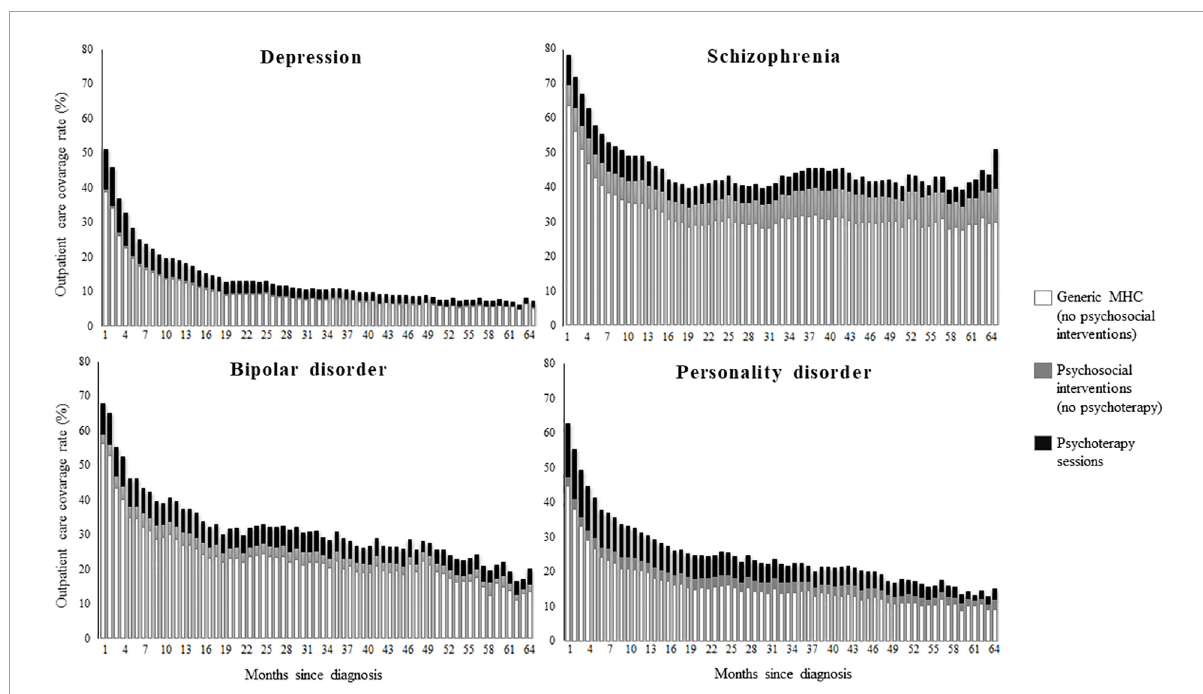
FIGURE3 Monthly coverage rate of contacts with the mental health service from the first until the 64th month after diagnosis of depression, schizophrenia, bipolar disorder, and personality disorder. Coverage was assigned to psychotherapy whether at least one psychotherapeutic session was performed, to psychosocial intervention whether at least any other psychosocial intervention was performed, to generic mental health care whether the patient attended the service without receiving neither psychosocial nor psychotherapeutic intervention. QUADIM-MAP project, Italy,